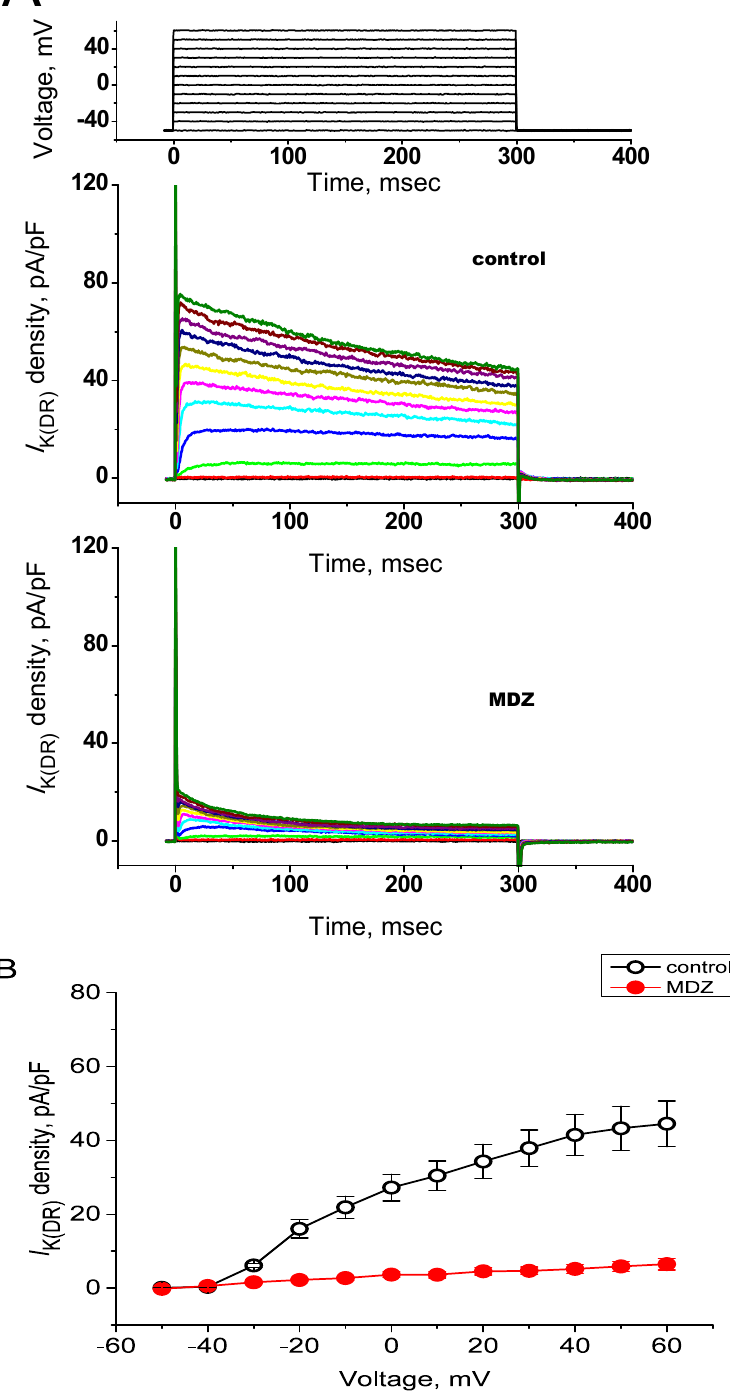
Figure 8. Effect of MDZ on I K(DR) density recorded from PHA-preactivated human T lymphocytes. ( A ) Superimposed current traces obtained in the absence (upper) and presence (lower) of 30 µ M MDZ. The uppermost part indicates the voltage protocol used. ( B ) Average current density versus voltage relationships of I K(DR) measured at the end of depolarizing pulses (mean ± SEM; n = 7–9 for each point). O: control; • : in the presence of 30 µ M MDZ.